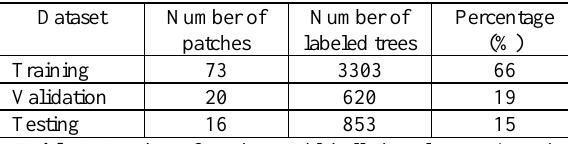
Table 1 . Number of patches and labelled apple trees in each dataset with the corresponding